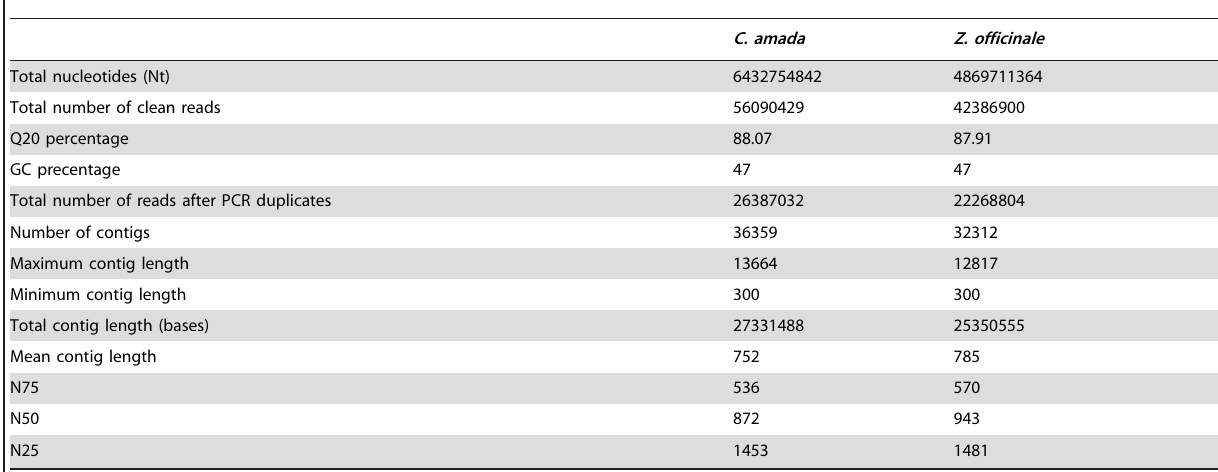
Table 1. Assembly summary of C. amada and Z. officinale.